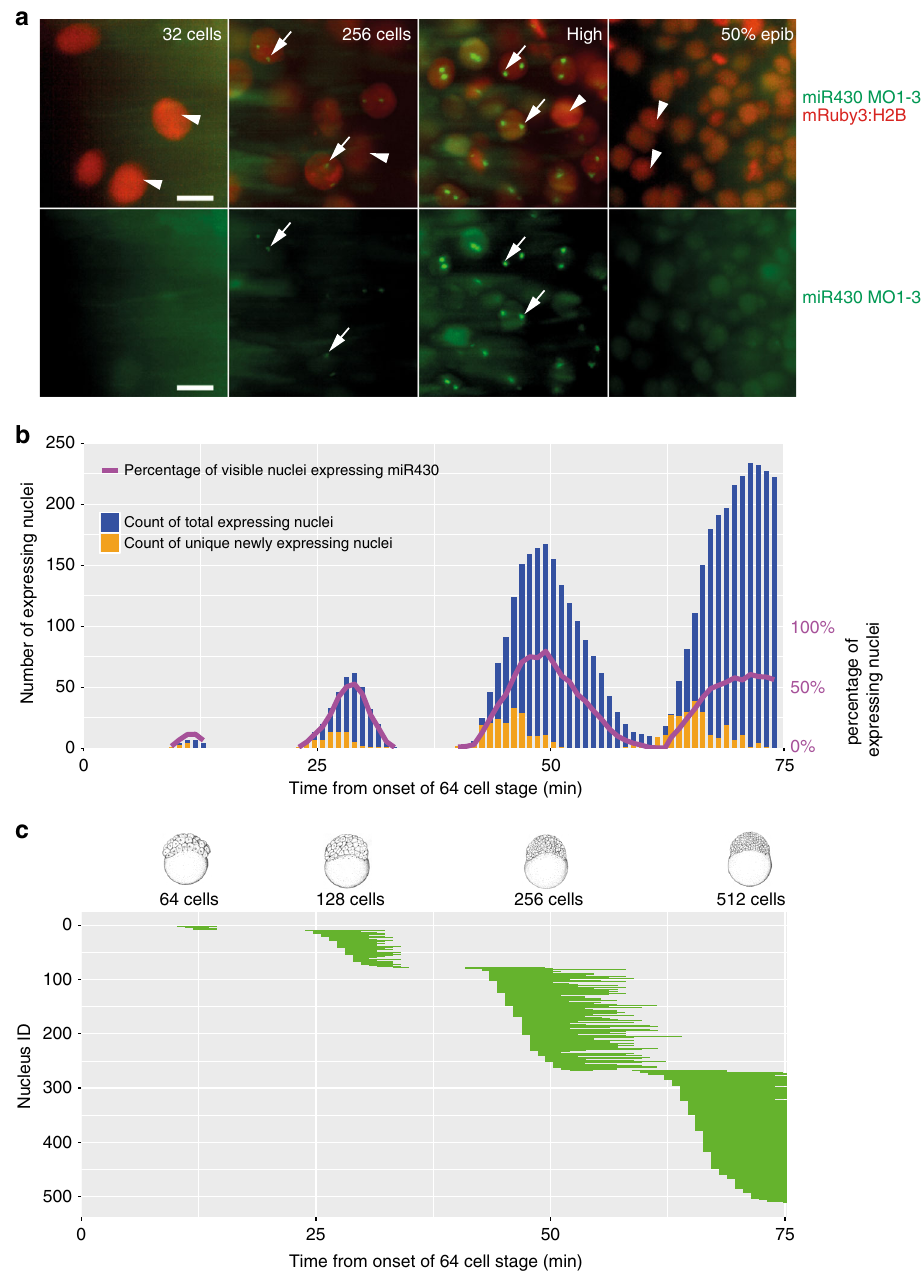
Fig. 3 Mapping of gene expression dynamics at cellular resolution indicates that metasynchrony and periodicity follows the short cell cycle phases. a Representative examples of simultaneous detection of miR430 expression by FITC-labelled MO in green (arrows) with mRuby3:H2B-labelled chromatin in red (arrowhead) during at stages as indicated. b Timing of the commencement of gene expression (orange) and number of nuclei (green) showing expression activity, total and new miR430 expressing nuclei per frame. Stages of development are indicated at the bottom of the panels, purple line represent percentage of nuclei expressing miR430 at the time and stages indicated. c Expression span of individual nuclei over time. Each horizontal bar represents the miR430 expression time of a single nucleus. Chart x -axis matches that in ( b ). Each bar represents signal from up to 2 foci per nucleus. The frame rate (51 s) was used as reference for the elapsed time in ( b , c ). 50% epib, 50% epiboly. Scale bars: a 10 µ m. Source data for ( b , c ) are provided as a Source Data fi le. Zebra fi sh embryonic stages schematics on panel ( b ) are reproduced from Kimmel et al., 1995, Developmental Dynamics 203:253-310 by permission of John Wiley & Sons, Inc.Source